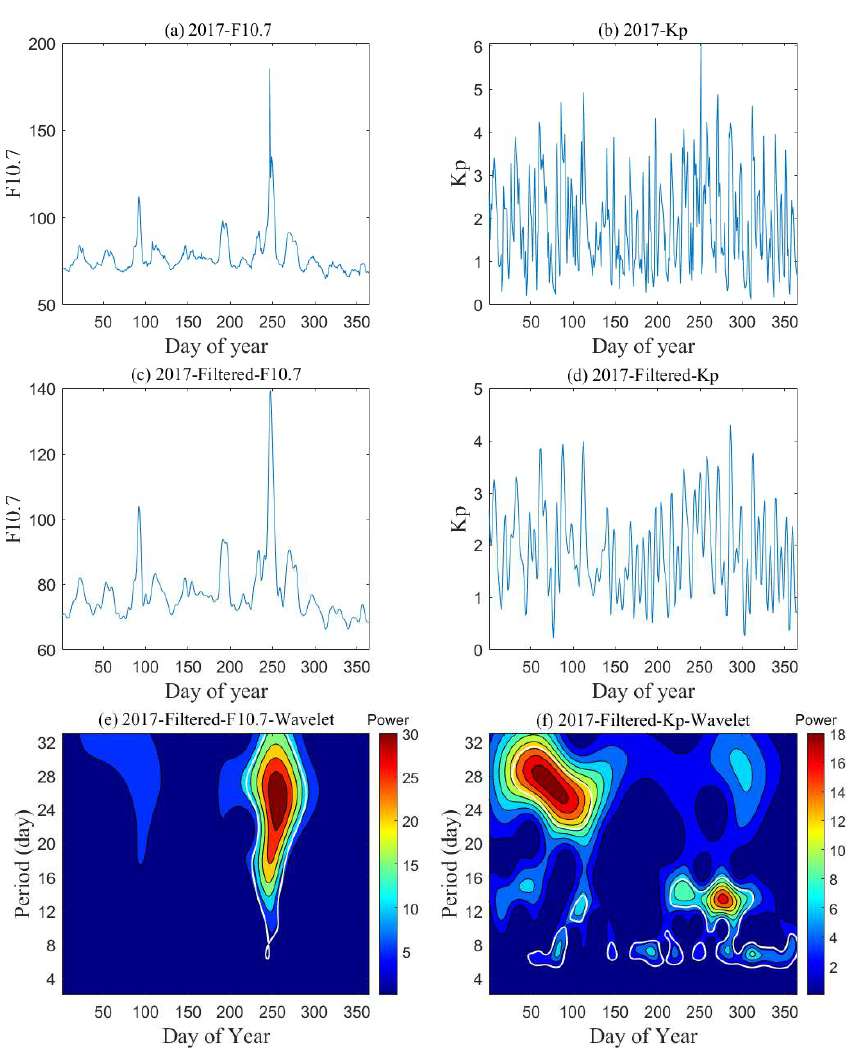
Figure 3. ( a , b ) The original data from the F10.7 (Kp) index during 2017. ( c , d ) The F10.7 (Kp) index during 2017 after filtering with a low-pass filter. ( e , f ) Wavelet spectrums of the filtered F10.7 (Kp) index during 2017.